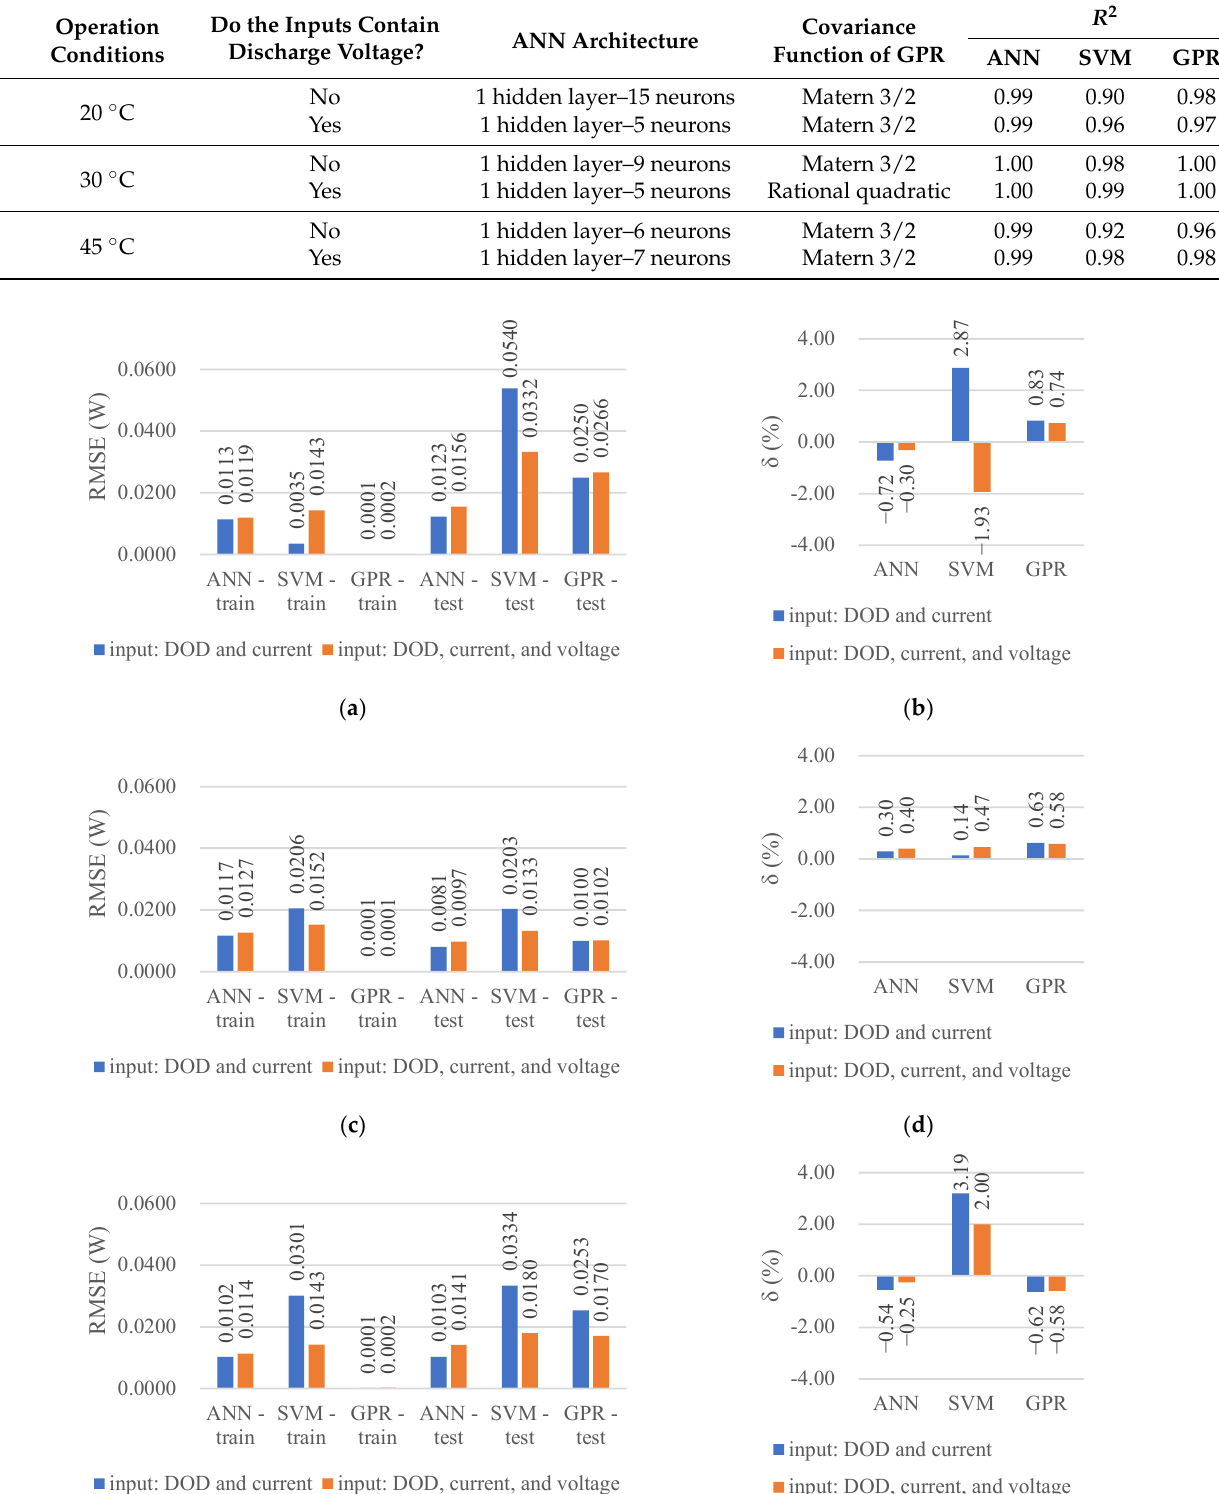
Table 3. ANN architectures and covariance functions of GPR that were used, and R 2 of the regressions.